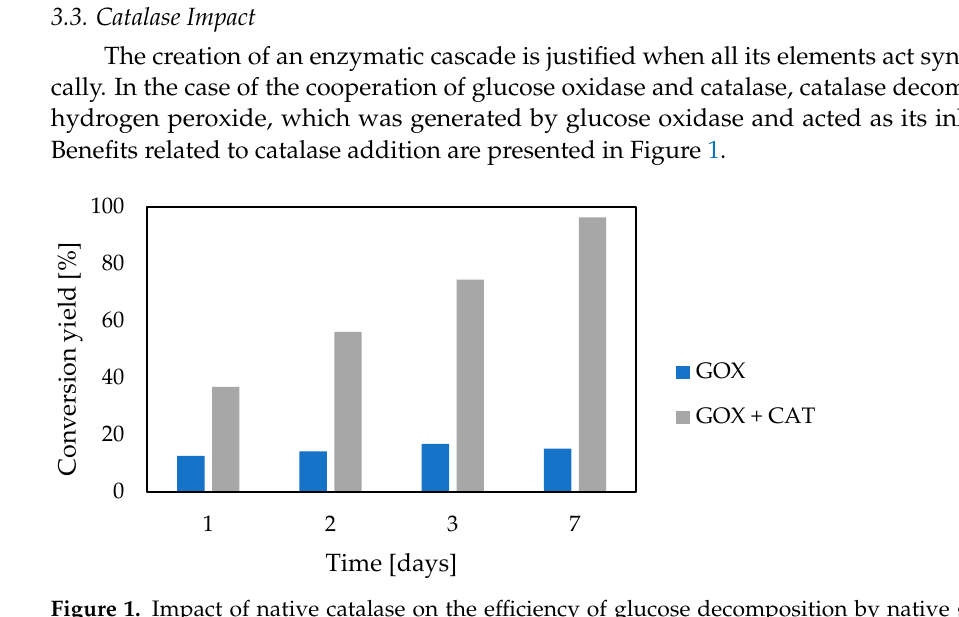
Figure 1. Impact of native catalase on the efficiency of glucose decomposition by native glucose oxidase (glucose 27.5 g/L, glucose oxidase 0.15 g/L, catalase 0.4 g/L, 0.1 M HEPES buffer pH 6.6, 12 °C, CaCO 3 4 g/L, without exogenous aeration).